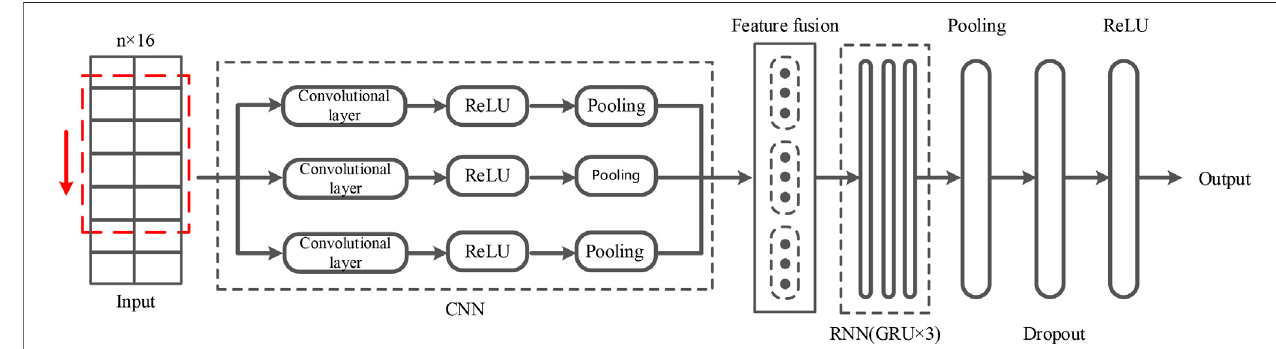
FIGURE 5 | The structure of spatiotemporal neural